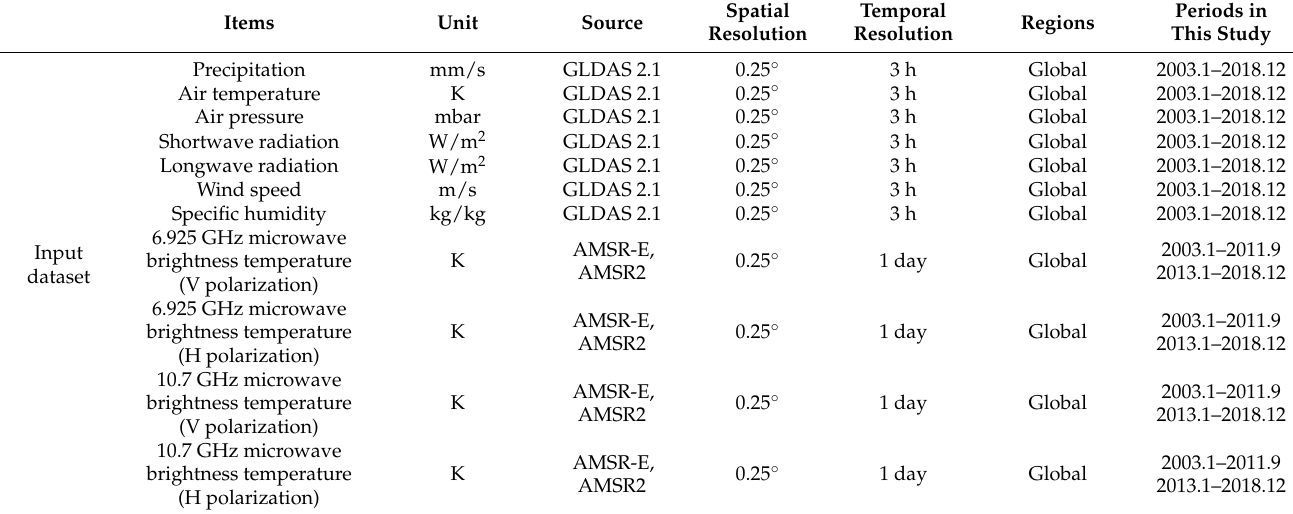
Table 1. List of input and output